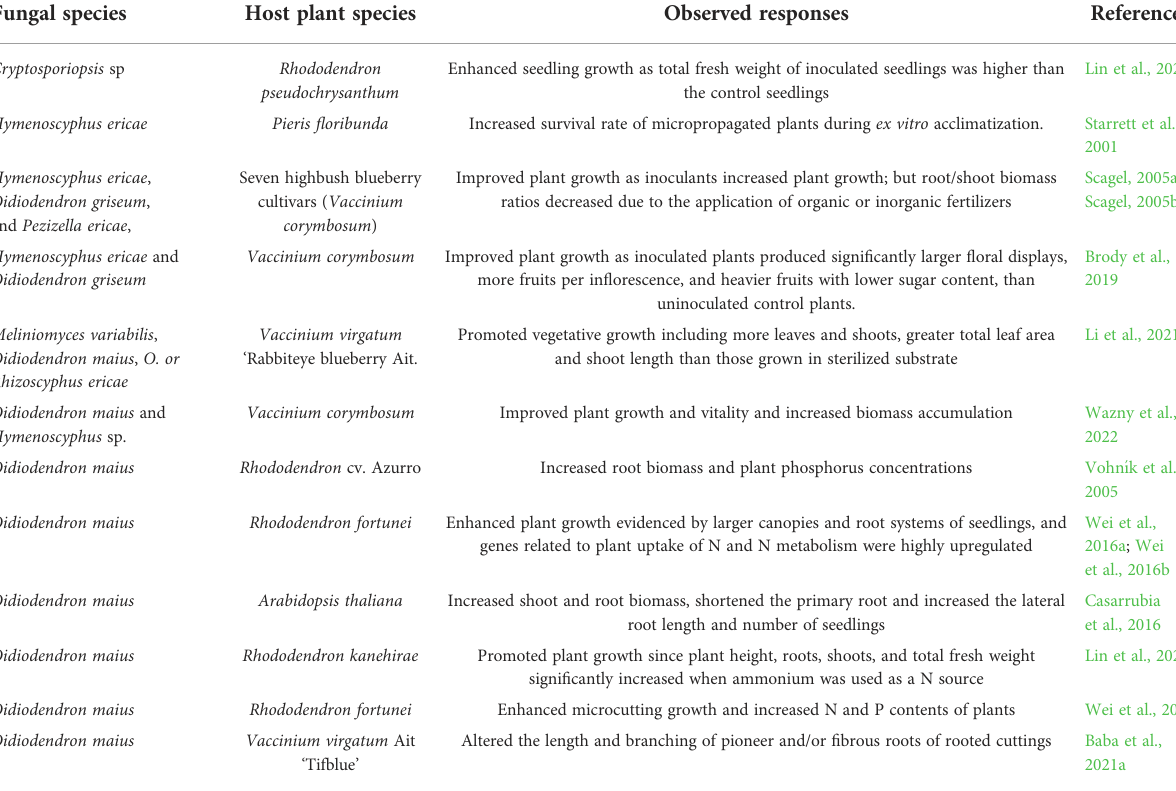
TABLE 3 Ericoid mycorrhizal fungi improve rooting of propagules and enhance plant growth. Fungal